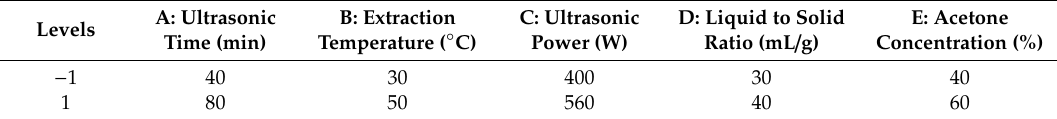
Table 1. Experimental design factors and levels of design of experiments.